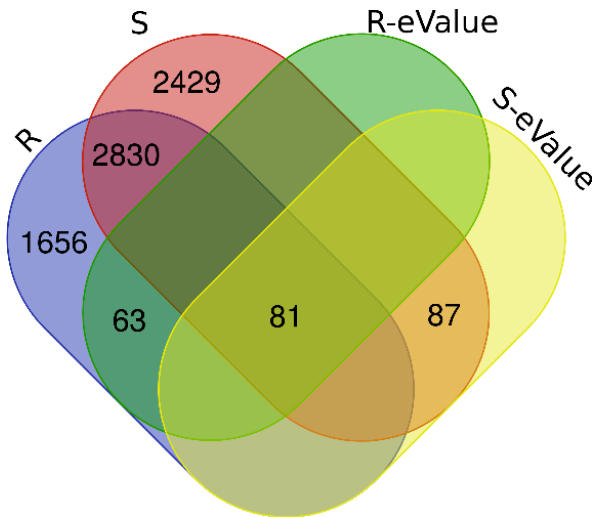
Figure 1. Venn diagrams showing the common and unique differ- entially expressed genes in S (red) and R (blue) genotypes detected (P-value < 0.05) and S-evalue (yellow) and R-evalue (green) based on e-value <1 × 10 –5 cut-off.